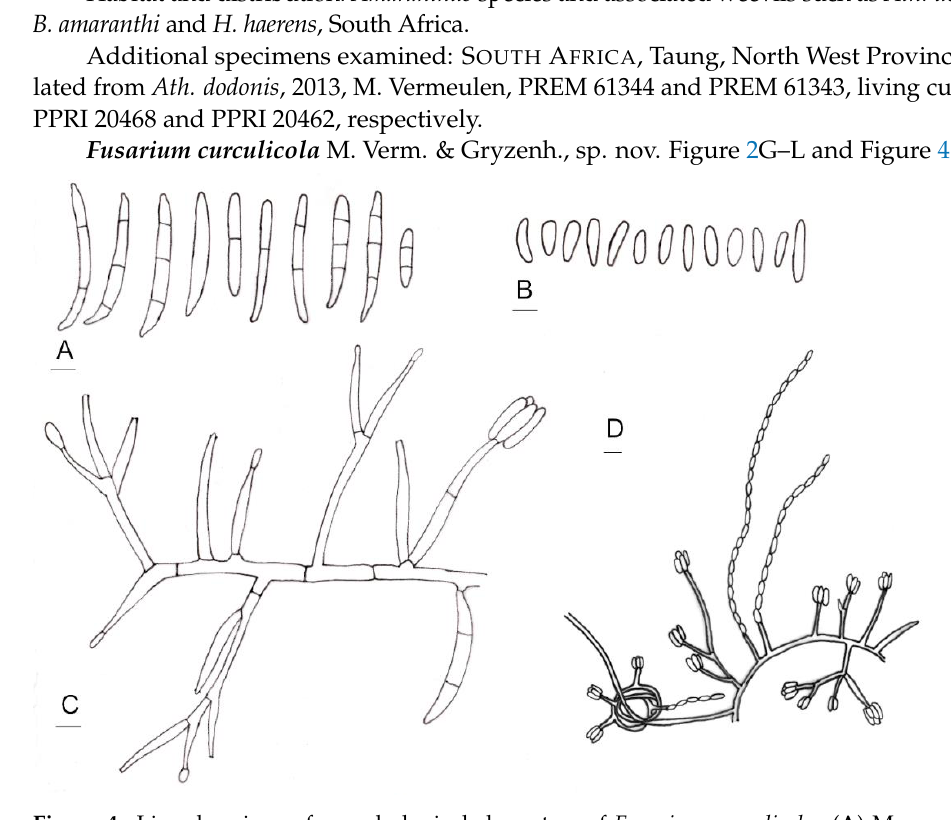
Figure 3. Line drawings of morphological characters of Fusarium casha . ( A ) Macroconidia. ( B ) Mi- croconidia. ( C ) Conidiophores and conidiogenous cells. ( D ) Conidia produced in false heads and hyphae coiling in circles. Bars: 5 µm.